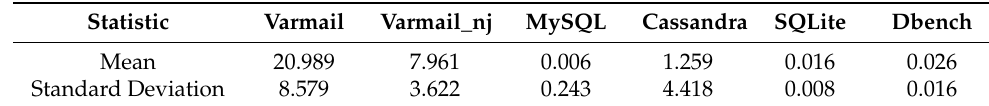
Table 1. Mean and standard deviation of append intervals.